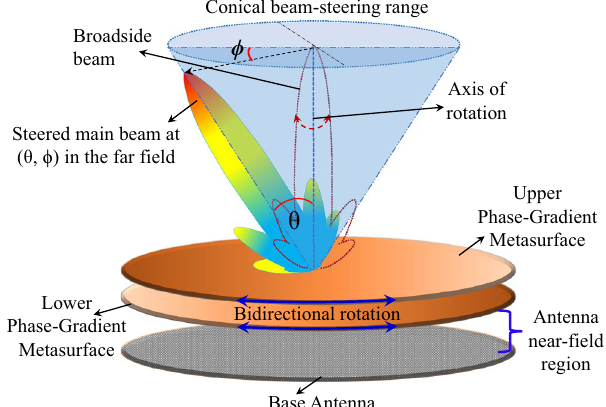
Figure 1. Configuration of classical Near-Field Meta-Steering